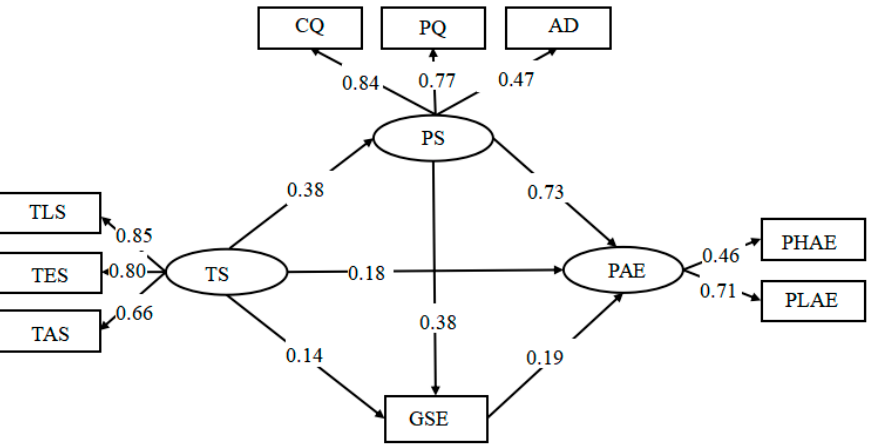
Figure 3. SEM with TS, PS, GSE, and PAE.